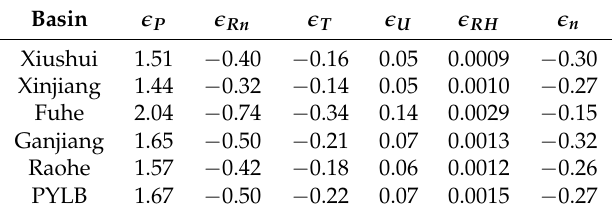
Table 4. Average climate elasticities across PYLB for 1960–2010. (cid:101) P , (cid:101) Rn , (cid:101) T , (cid:101) U , (cid:101) RH and (cid:101) n represent precipitation elasticity, net radiation elasticity, temperature elasticity, wind speed elasticity, relative humidity elasticity and catchment properties’ parameter elasticity, respectively. Basin (cid:101) P (cid:101)